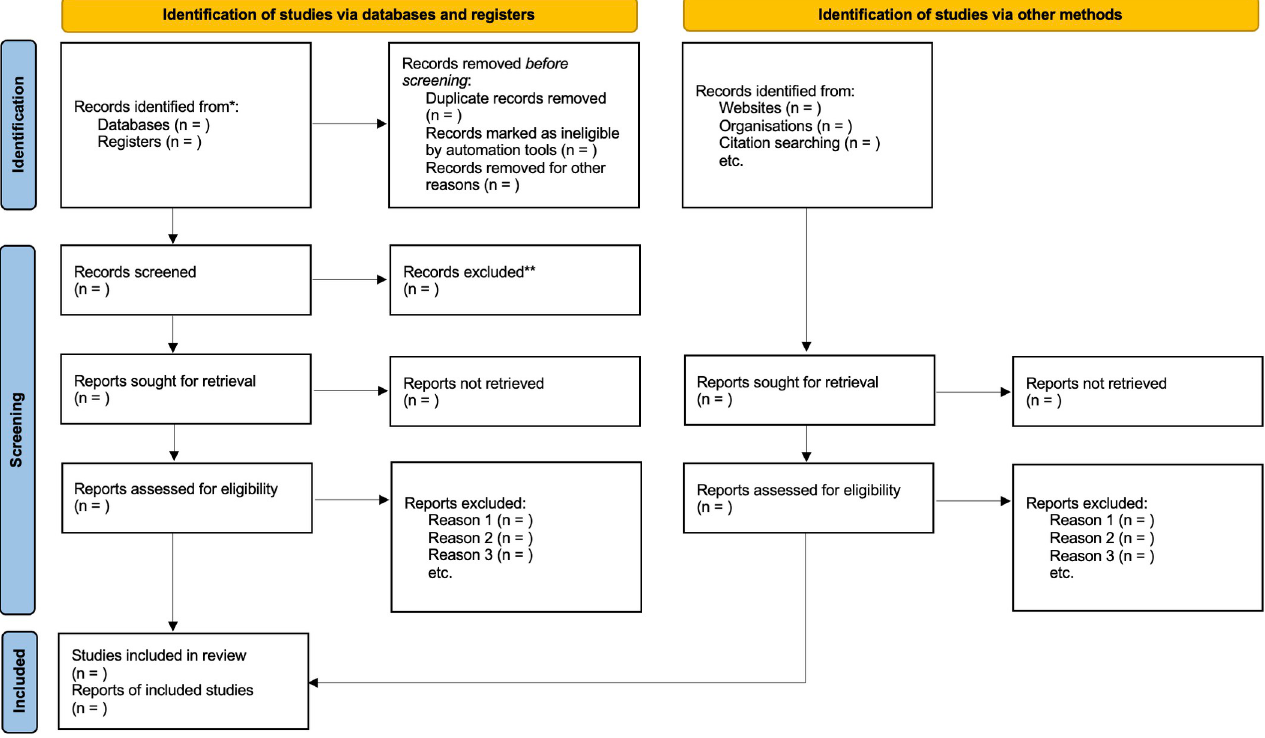
Fig 1. PRISMA flowchart